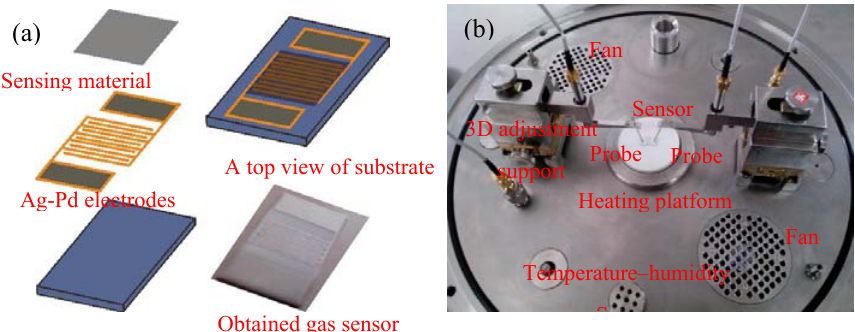
Figure 1. ( a ) Schematic micrograph of the planar ZnO-based gas sensor and obtained gas sensor [inset in ( a )]; ( b ) A photograph of the gas sensing analysis